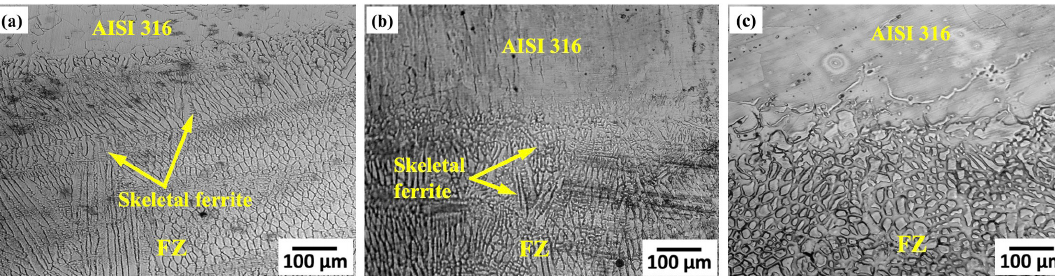
Figure 9. Microphotography of areas adjacent to fusion boundary at stainless steel side with different welding conditions (a) 600A, 0.3s, no Ni (b) 600A, 0.3s, with Ni (c) 800A, 0.3s, with